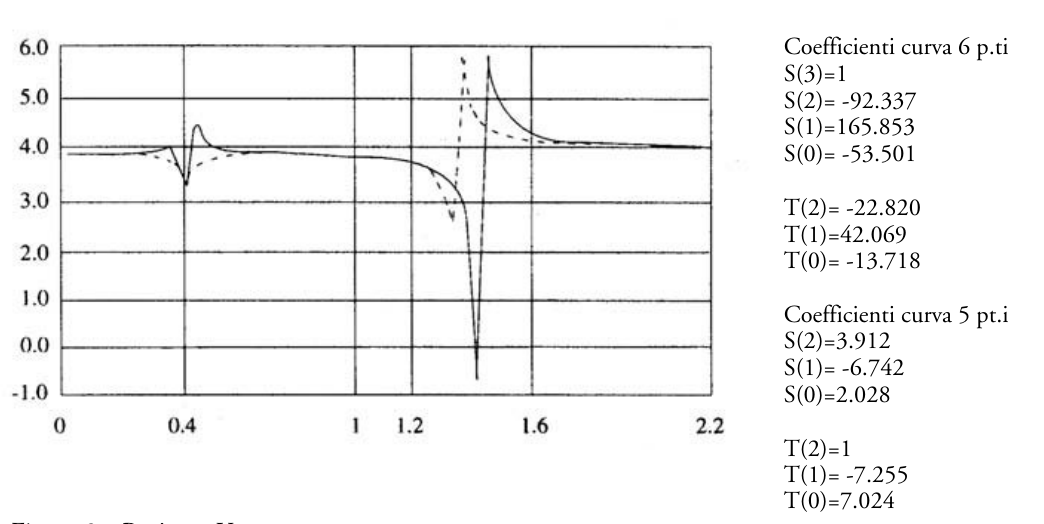
Figura 8 – Paziente